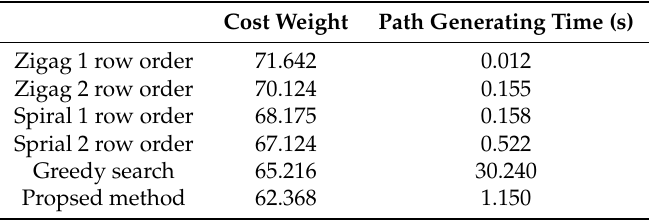
Figure 14. Comparison results between methods for an 11 × 11 workspace. ( a ) Zigzag scanning 1 row order; ( b ) Zigzag scanning 2 row order; ( c ) Spiral scanning 1 row order; ( d ) Spiral scanning 2 row order; ( e ) Greedy search; ( f ) Proposed method. Table 1. Comparison results of path planning